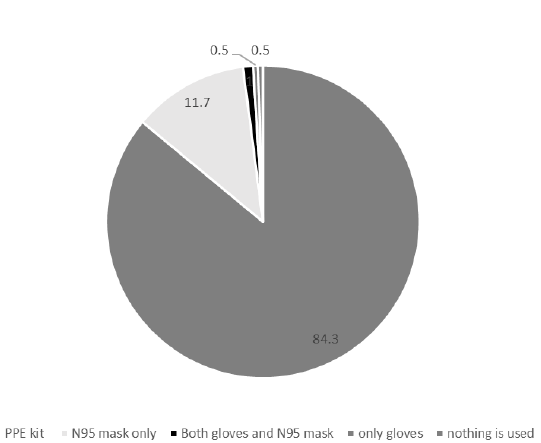
Figure 1: Use of personal safety